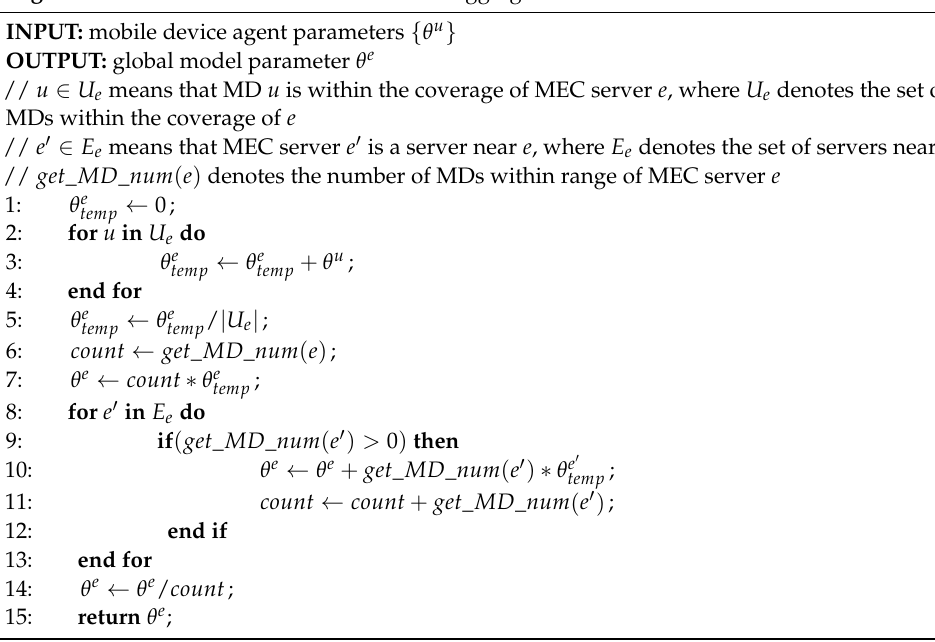
Algorithm 2 FDRT’s MEC Server Parameter